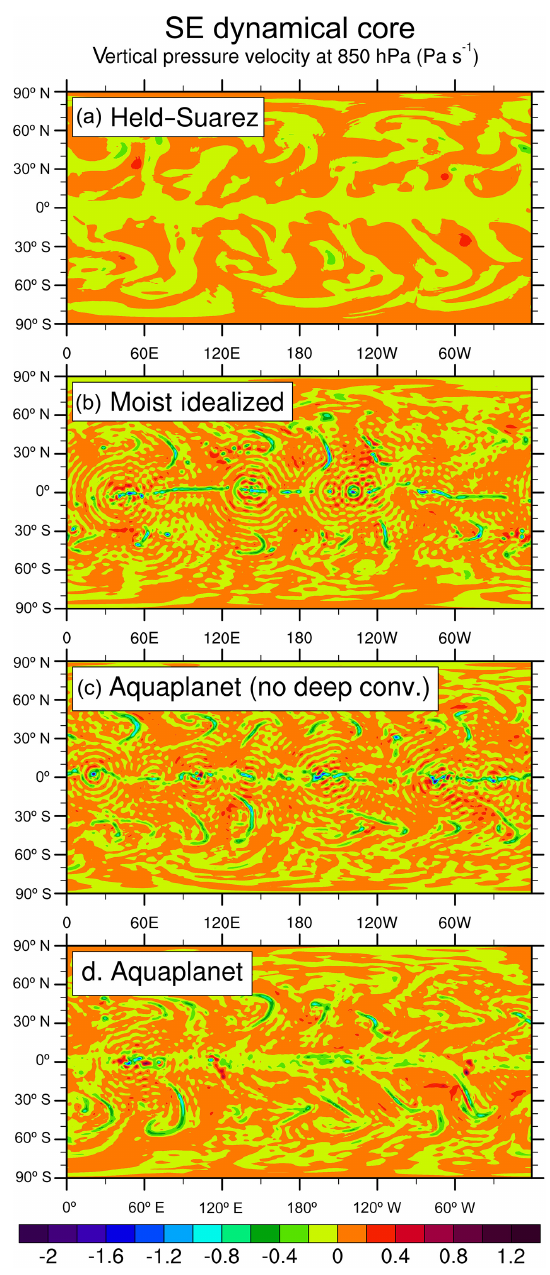
Figure 8. Instantaneous latitude–longitude snapshots of the 850hPa vertical pressure velocity in CAM5-SE for the (a) dry Held–Suarez test case, (b) MITC, (c) APS (NDC), and (d) APS.